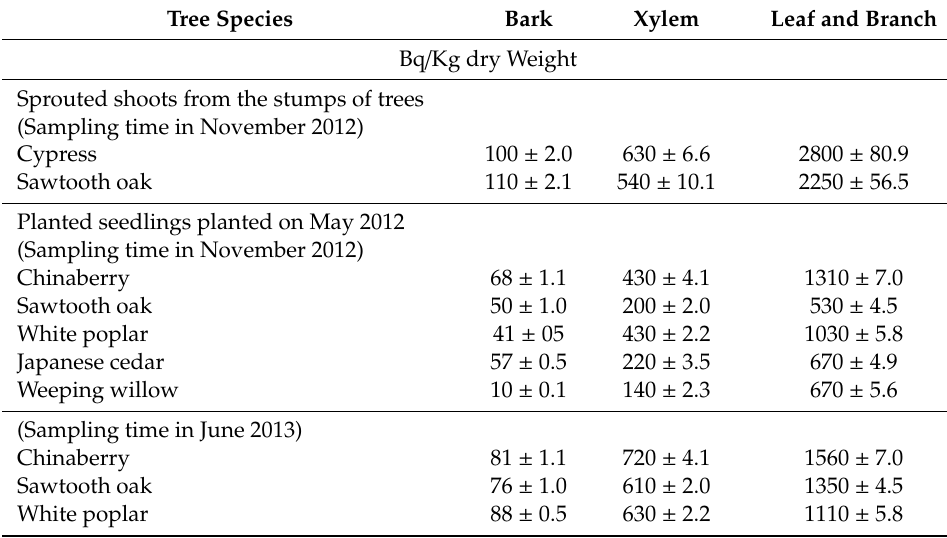
Table 3. Incorporation of radiocesium ( 134 Cs and 137 Cs) into trees either developed from the stumps of trees or planted in the forest after the accident (Figure 1: area number 2). The total radiocesium ( 134 Cs and 137 Cs) in this field was 1.21 MBq / m 2 , most of which was present in litter and mulch (80%) and soil